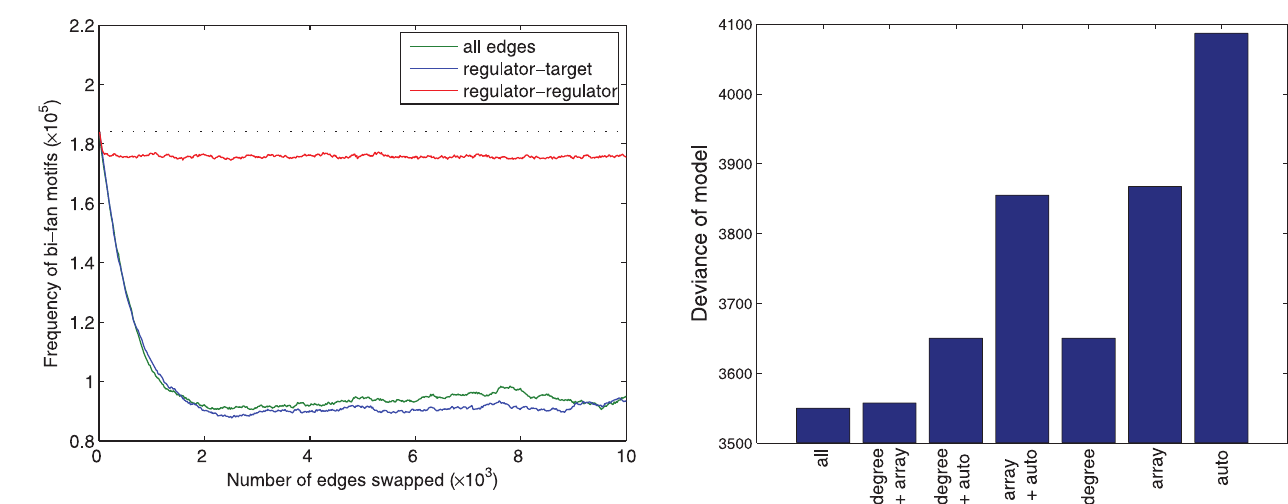
Figure 6. Error of Generalized Linear Models When Used to Fit the Probability of a Transcriptional Regulatory Interaction between a TF and a Second TF ‘‘ all ’’ refers to models trained on the out-degree, the number of targets shared by the pair of TFs ( ‘‘ array ’’ ), and a binary variable representing the presence of an autoregulatory interaction in the target TF ( ‘‘ auto ’’ ). A comparison is shown with linear models trained on subsets of these three variables.